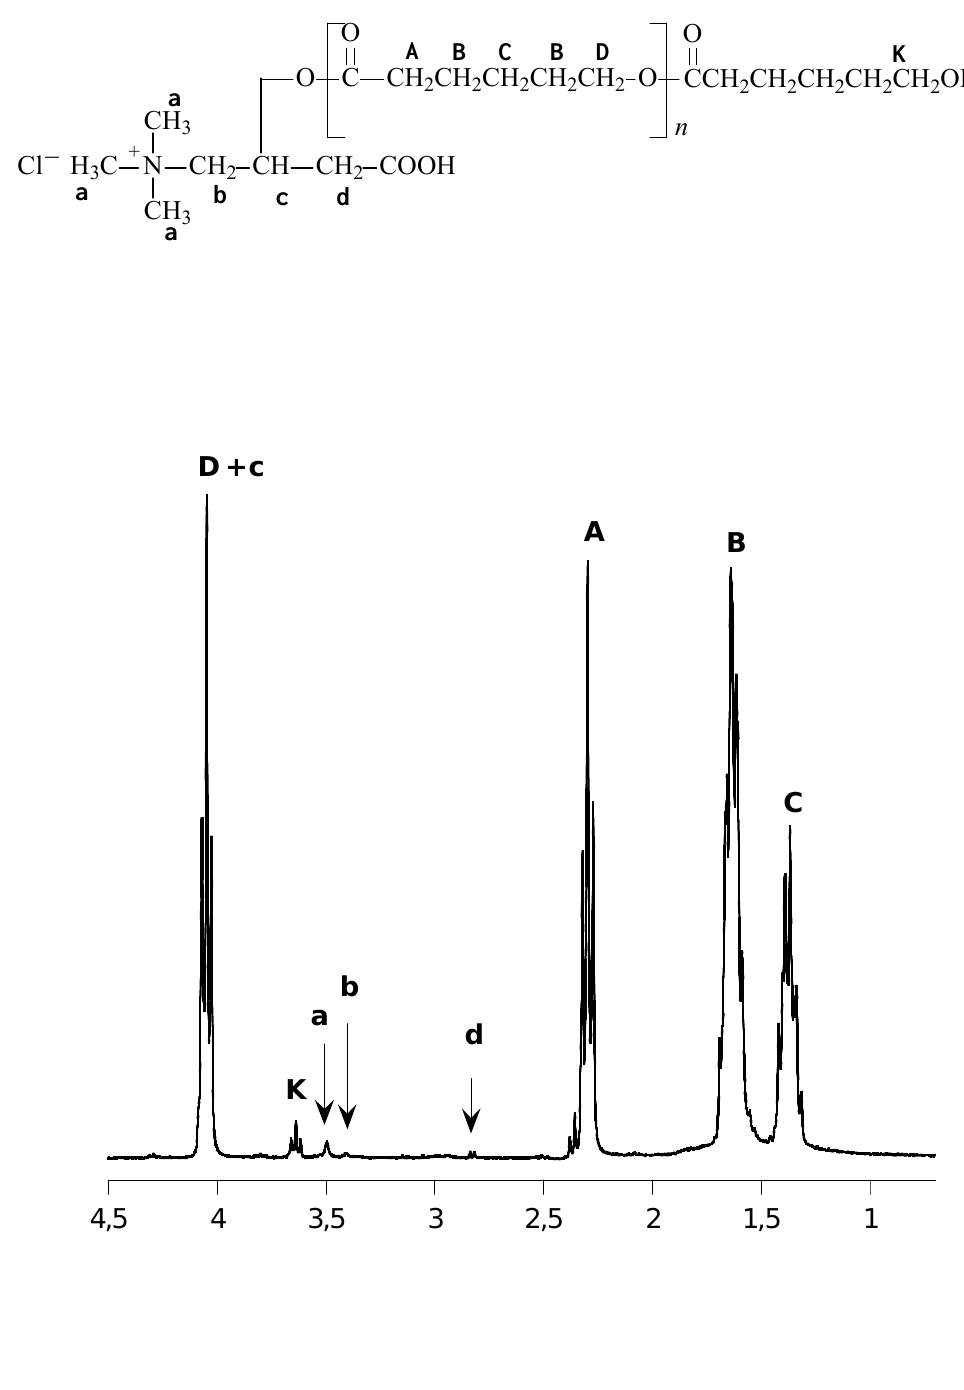
Figure 1. 1 H-NMR spectra of the CL homopolymer produced in the presence of carnitine and SnOct 2